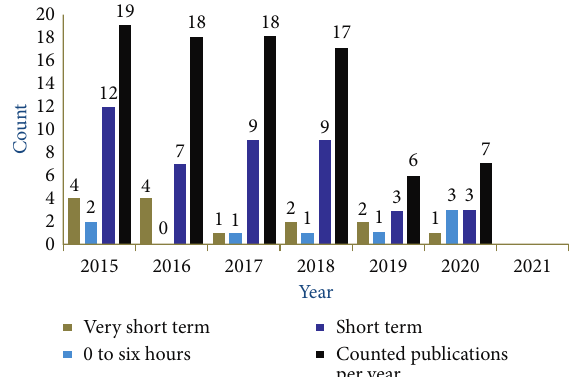
Figure 3: Research papers discussed by this review paper since